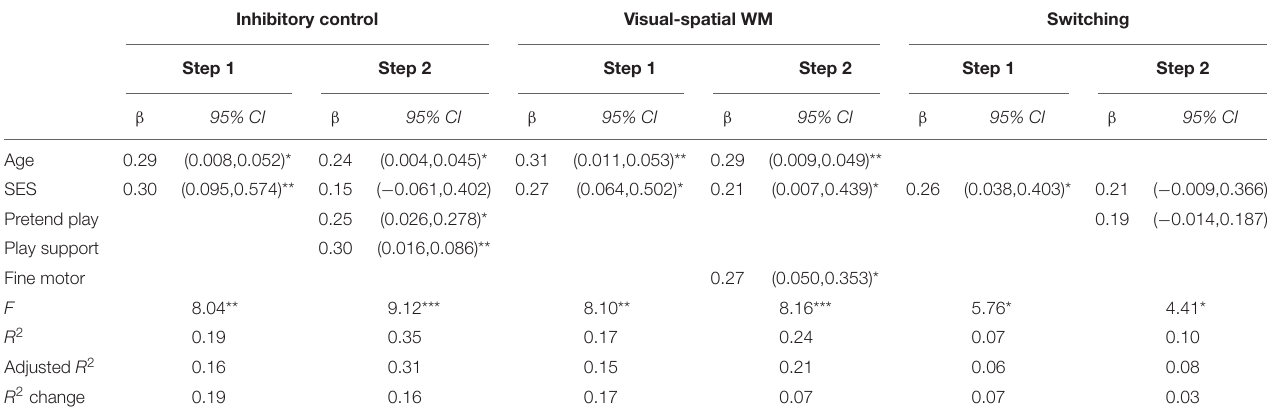
TABLE 6 | Hierarchical multiple regression models summary predicting inhibitory control, visual-spatial working memory and